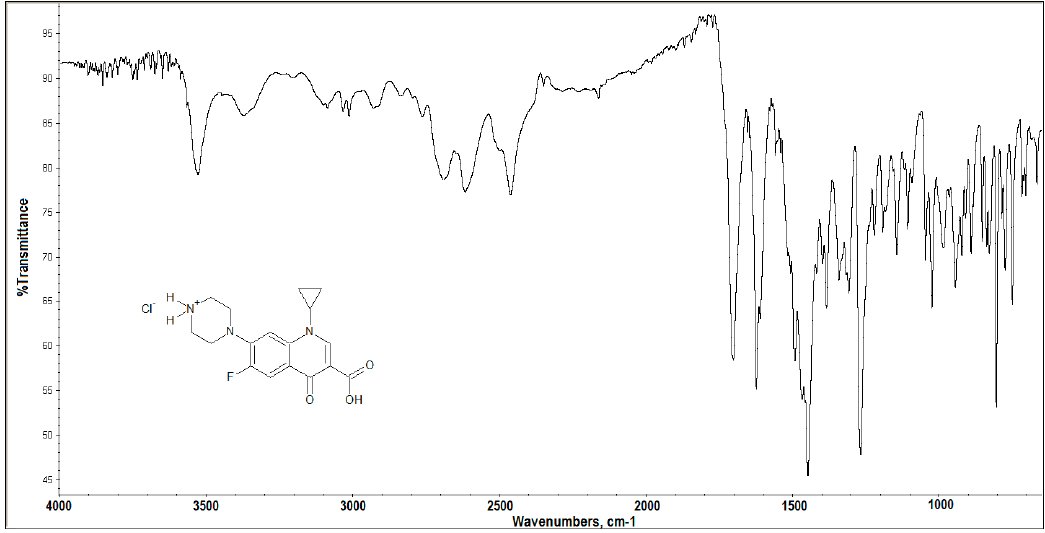
Figure 6. FTIR spectrum of ciprofloxacin hydrochloride monohydrate.